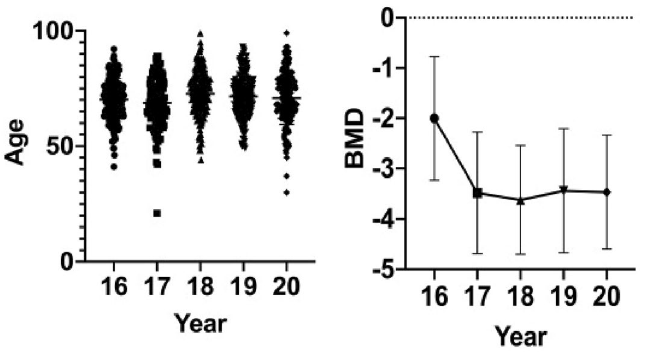
Figure 1. The distribution of age and